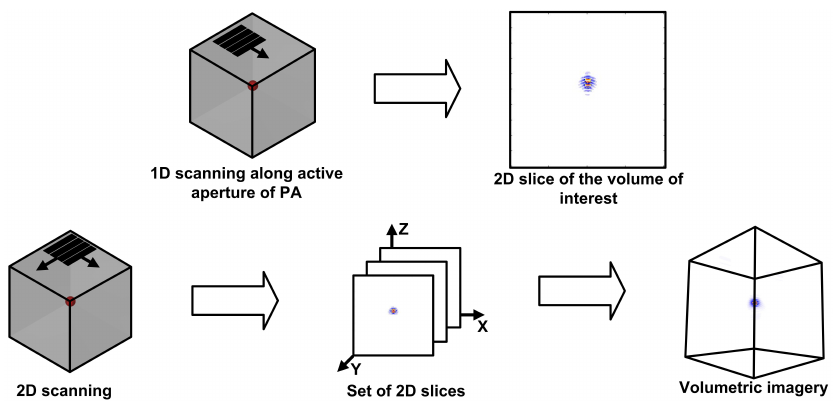
Figure 1. The principle of 3D imagery acquisition by the application of a linear phased array